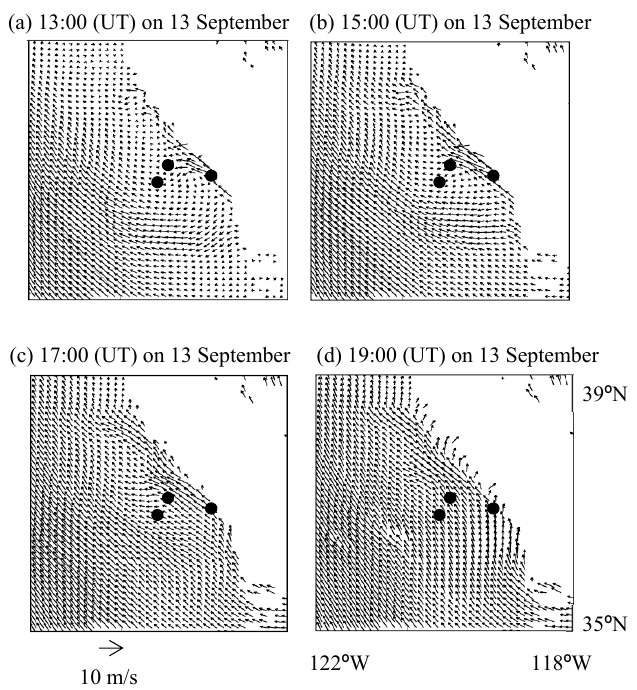
Figure 11. Wind behavior at an altitude of 850 hPa with the correct topographical effects in Area-S, simulated using a regional SCALE model (resolution of 5 km × 5 km). Images are given for each 2-hour period between 13:00 and 19:00 (UTC) on 13 September 2020 ( a – d ). The black dots denote the three AERONET observation sites.